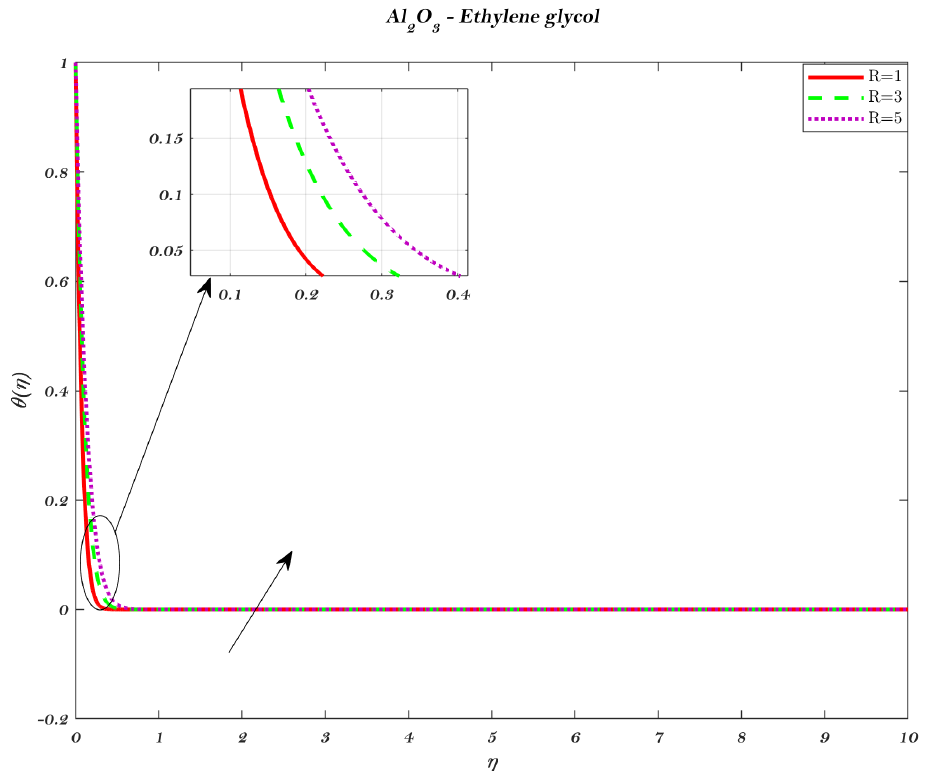
Figure 17. The radiative heat flux R against η with fix parameters ϕ = 2%, ˘ a = 0.02 and P r = 204.